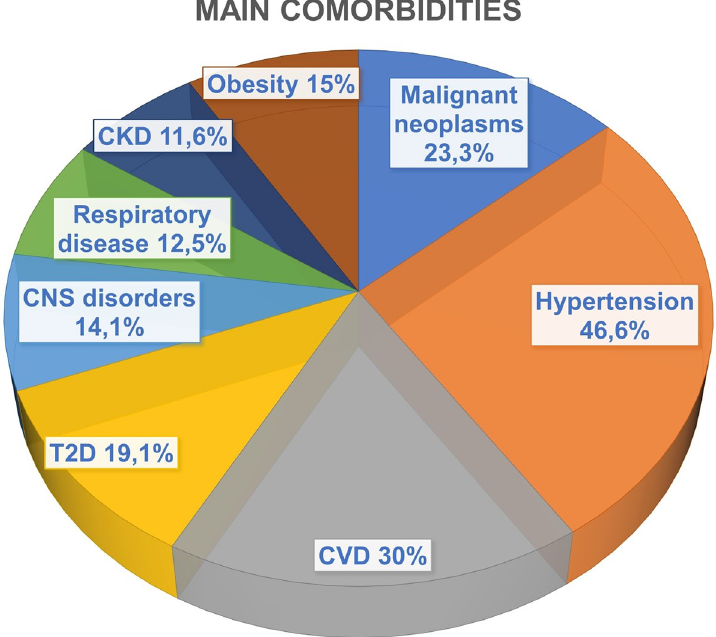
Fig 1. Main comorbidities of COVID-19 patients admitted in IMU. Abbreviations: CKD, chronic kidney disease; CNS, central nervous system, CVD, cardiovascular disease; T2D, type 2 diabetes.